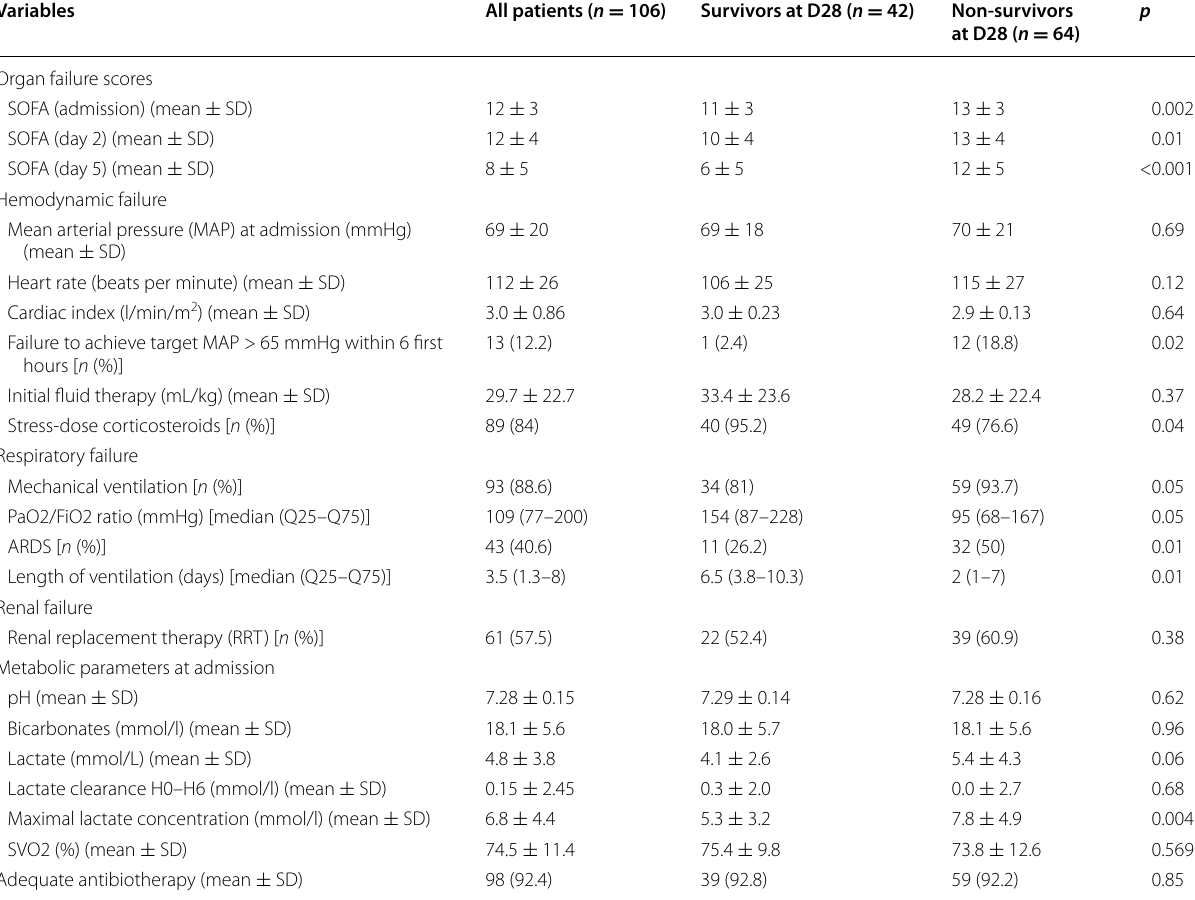
Table 2 Comparison of organ failures and septic shock treatment according to survival Variables